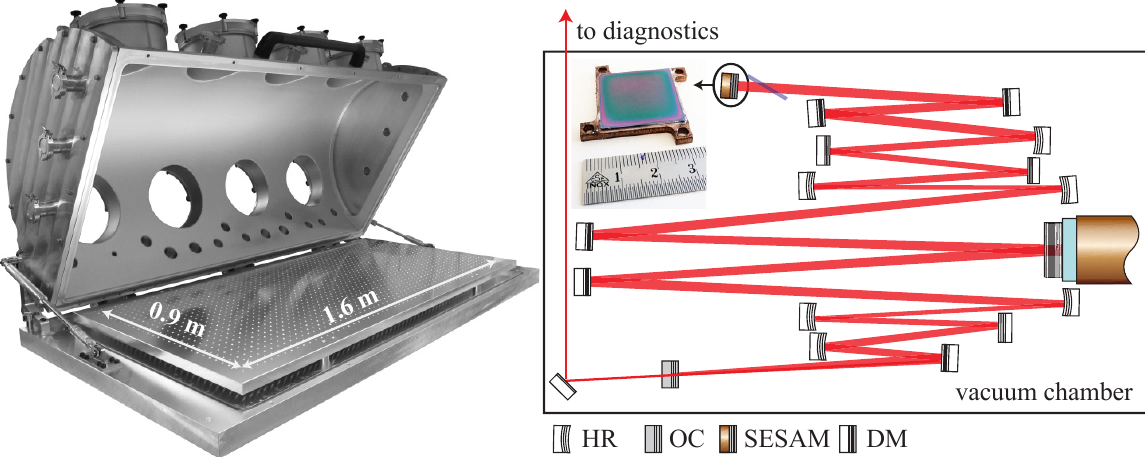
16.3 MHz pulse repetition rate fundamental transverse mode cavity used for the high-power modelocking experiment. Inset: Picture of large scale SESAM used for this